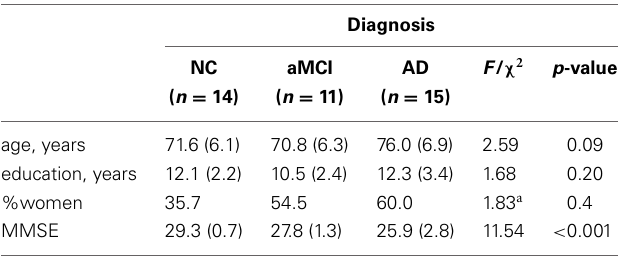
Table 1 | Demographic characteristics and MMSE scores of the NC, aMCI, and AD groups [mean (standard deviation)].